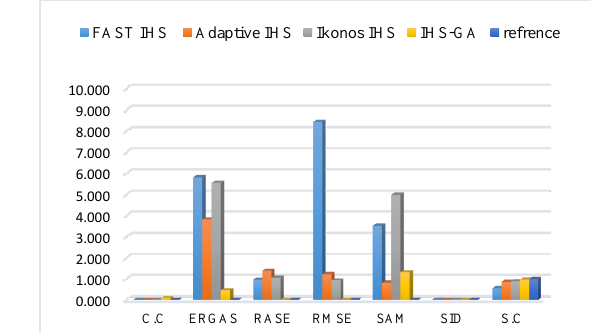
Table 2: Assessing the fusion methods (Quickbird data set)